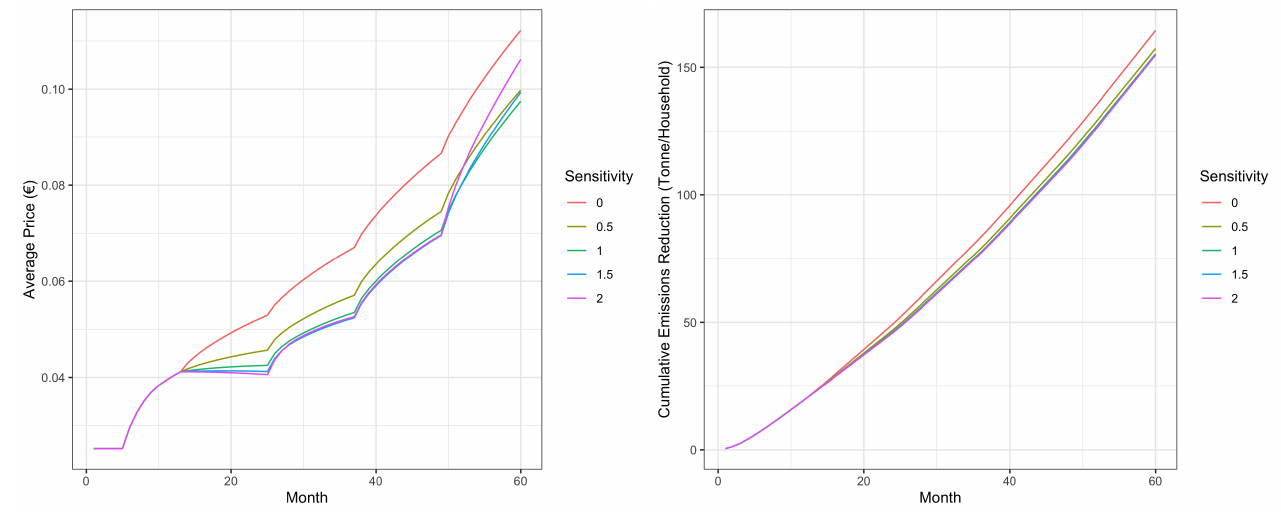
Figure 2. ( a ) demonstrates that the average price for allowances increases over time depending on the sensitivity chosen at the simulation start. ( b ) illustrates that cumulative emission reductions over time slightly depend on the sensitivity levels of the simulations.